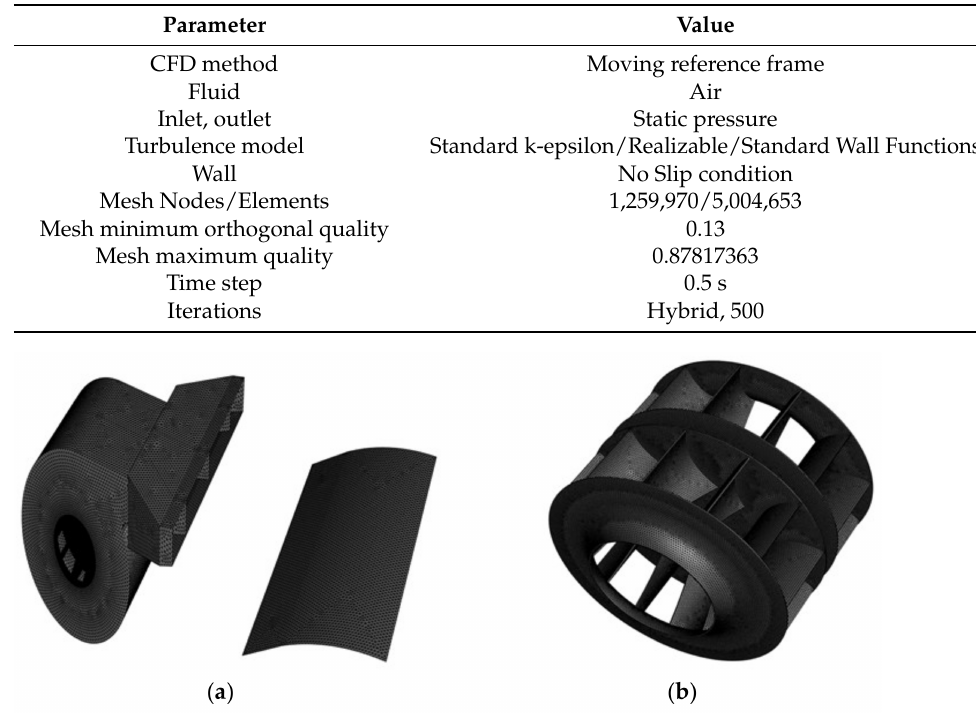
Figure 5. Mesh composition of ( a ) a blowing fan and ( b ) the main impeller.